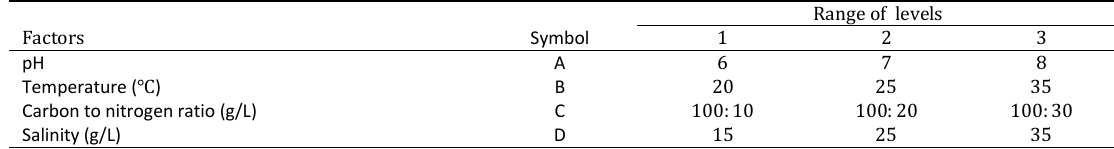
Table 1: The range of levels of various factors